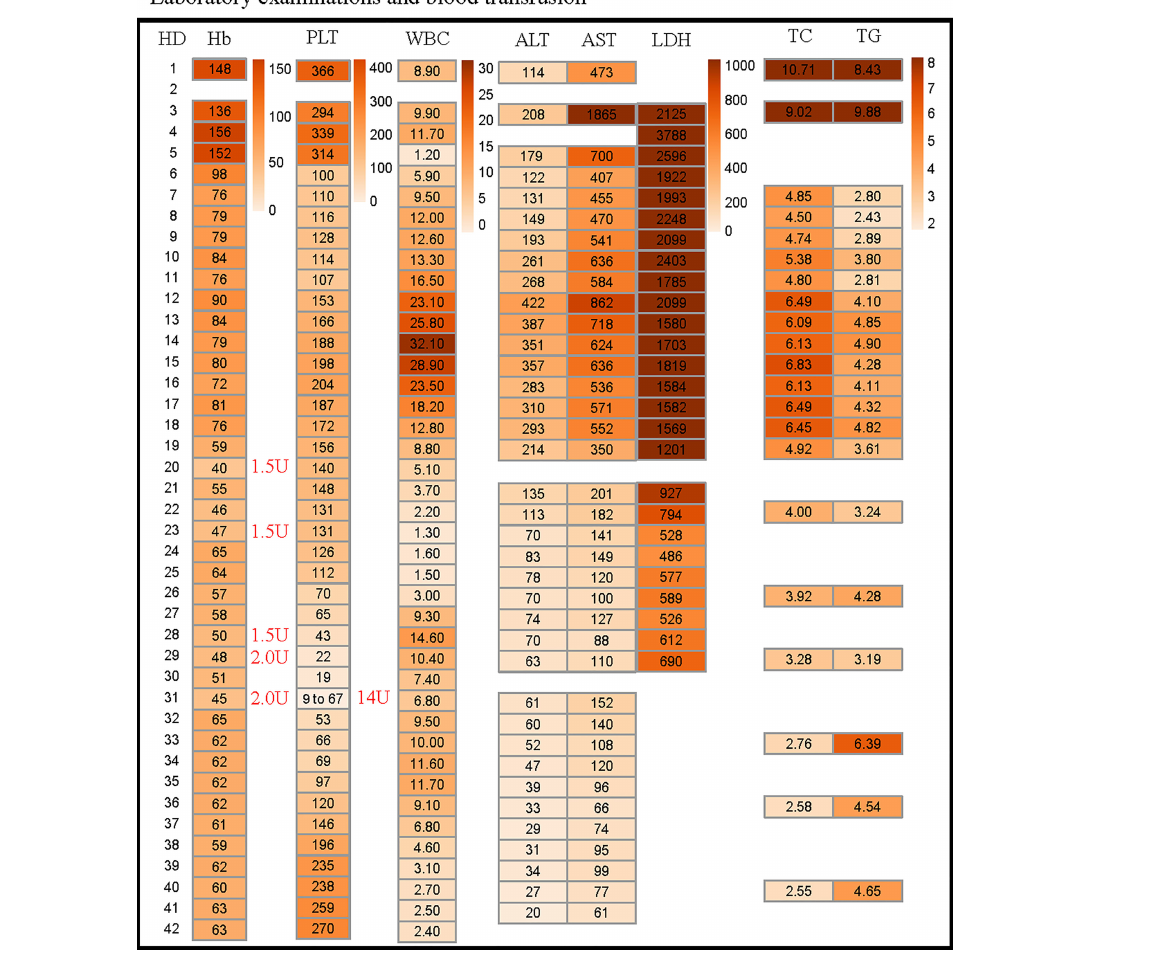
FIGURE 3 | Changes in patient ’ s blood routine, liver function within 42 days after admission. The reference range for each variable are shown in Table 1 . The amount of red blood cells and platelet administered to the patient are marked with red font on the right side of the corresponding time. HD, hospitalization day; Hb, hemoglobin; PLT, platelets; WBC, white blood cell; ALT, alanine aminotransferase; AST, aspartate aminotransferase; LDH, lactate dehydrogenase; TC, total cholesterol; TG,